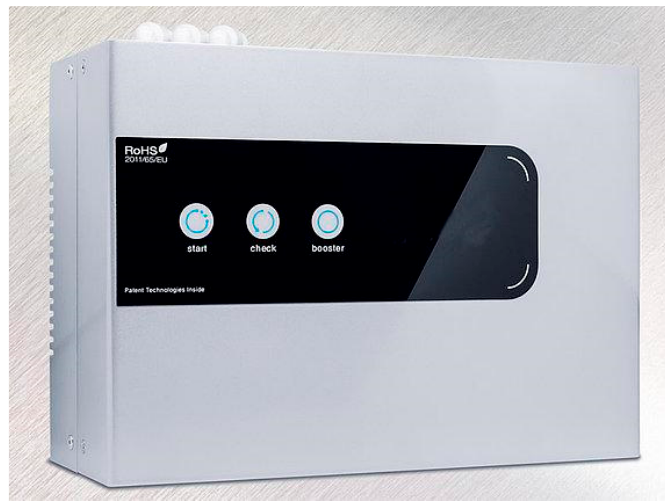
Figure 6. Hydrogen (H ₂ ) concentration of EVOdrop hydrogen water (1.2 ppm). Correspondence of hydrogen concentration (ppb) of EVOdrop hydrogen water and the DC Current (Ampers).